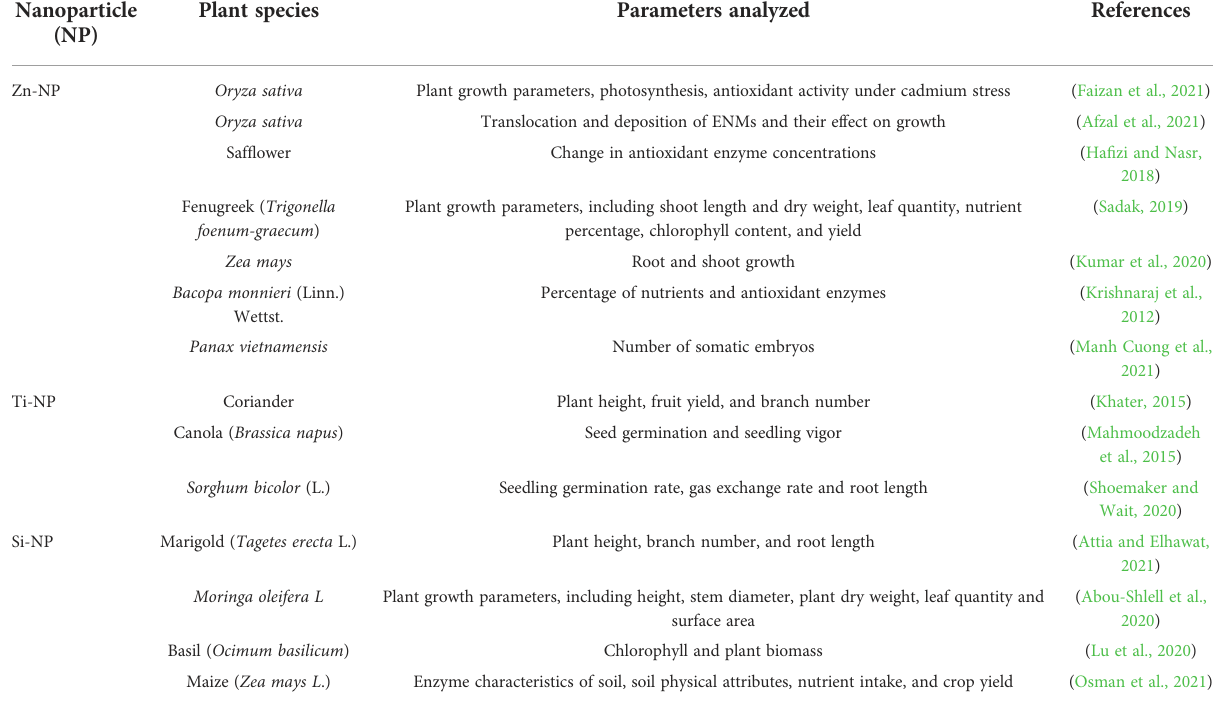
TABLE 4 Application of engineered nano materials to enhance plant growth and other eco- physiological parameters.